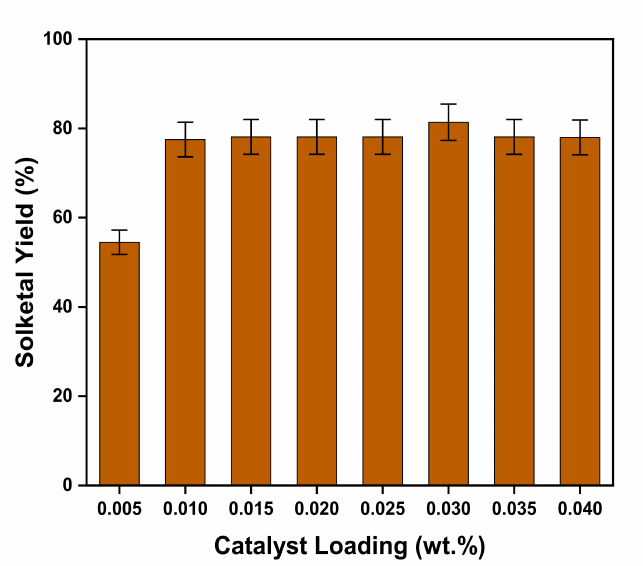
Figure 6. Influence of catalyst loading on solketal